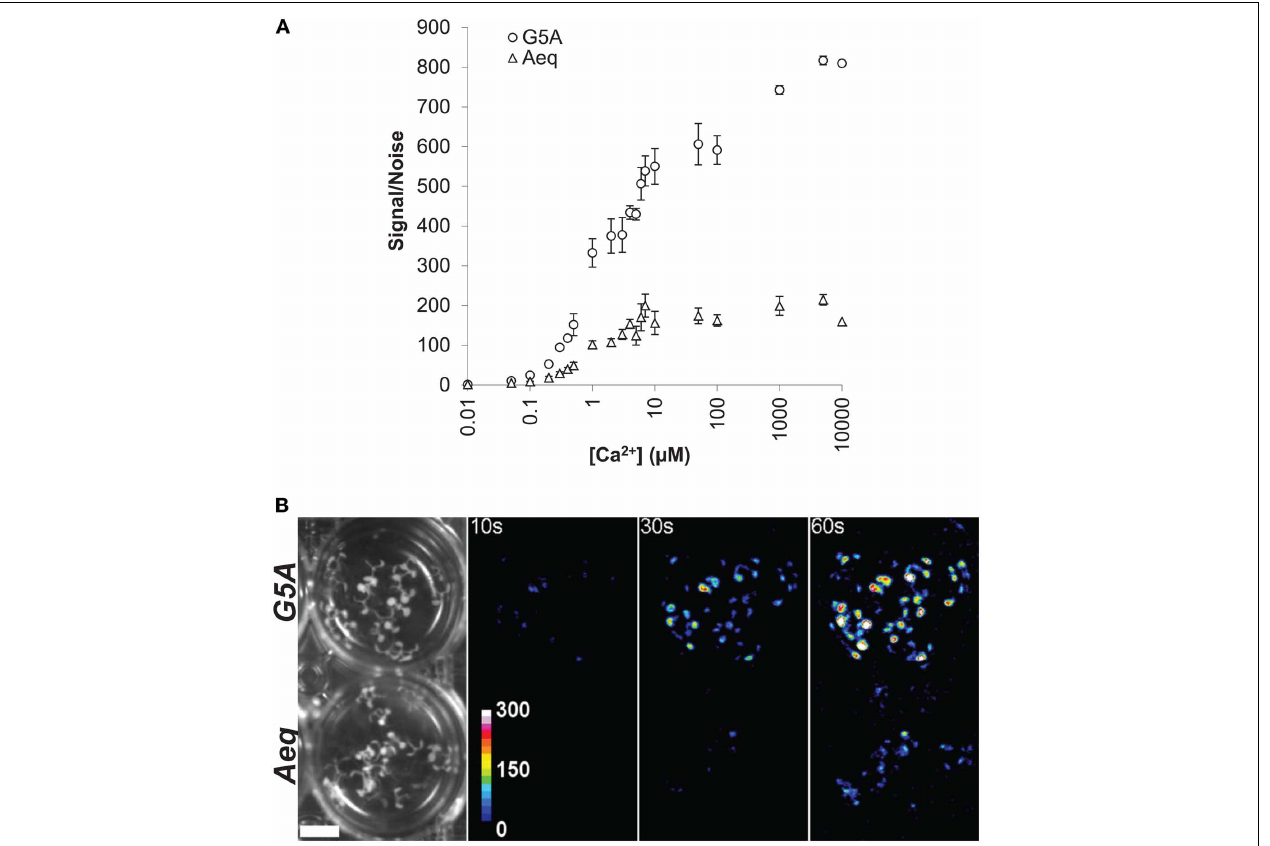
FIGURE 4 | In vitro and in vivo comparison of light emission by G5A and aequorin (A) In vitro assay of light emission from equal amounts of Ca 2 + reporters G5A and aequorin is plotted against buffer free Ca 2 + concentration. Results (mean ± SE, n = 6) are expressed as the ratio of signal (maximum emitted light) over noise. (B) Representative in vivo